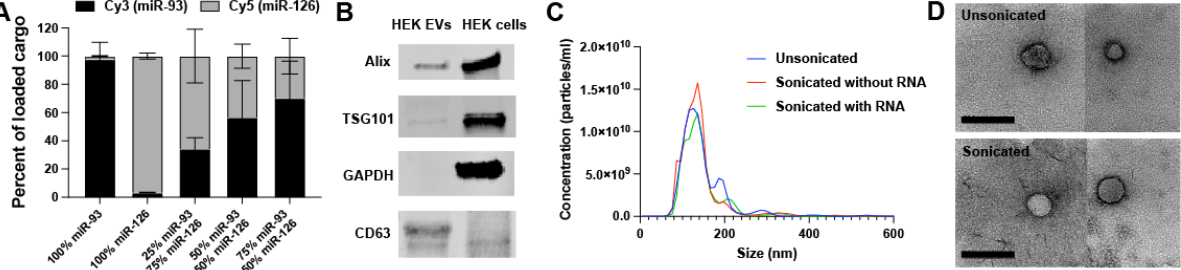
Figure 1. EV characterization and co-loading validation. ( A ) Relative quantification of co-loaded fluorescently tagged miRNA mimics. ( B ) Western blot of EVs vs. parental cells. ( C ) Nanoparticle Tracking Analysis (NTA) performed on EVs that were unsonicated, sonicated, and sonicated with miRNA. ( D ) Transmission electron micrographs (TEM) of unsonicated and sonicated EVs. Scale bar = 200 nm.